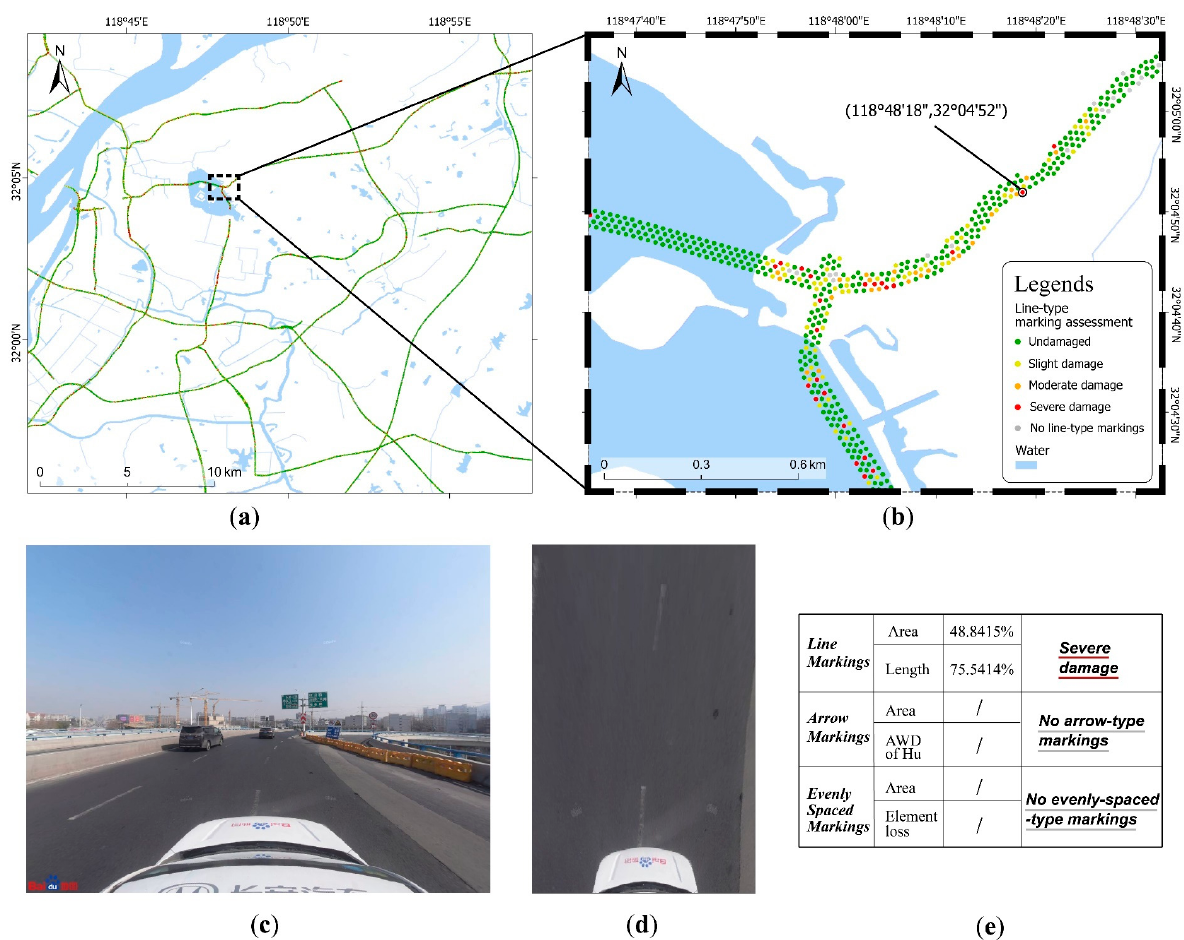
Figure 13. An example of pavement markings on the road near the exit of Jiuhuashan Tunnel. ( a ) Approximate location in Nanjing City, ( b ) explicit position of the images captured at the sampling point, ( c ) original street-view image of the sampling point, ( d ) converted birds’-eye view of the panel ( c ), ( e ) assessment of pavement markings at the sampling point.